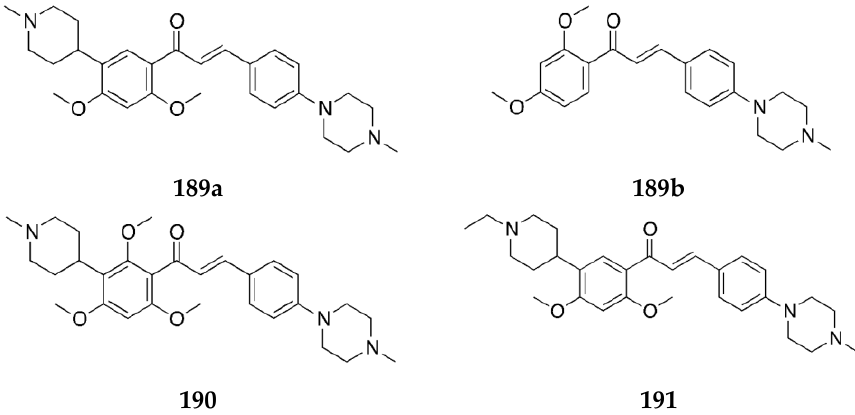
Figure 62. Chemical structure of methylated piperazine-substituted 4′-aminochalcone derivatives.